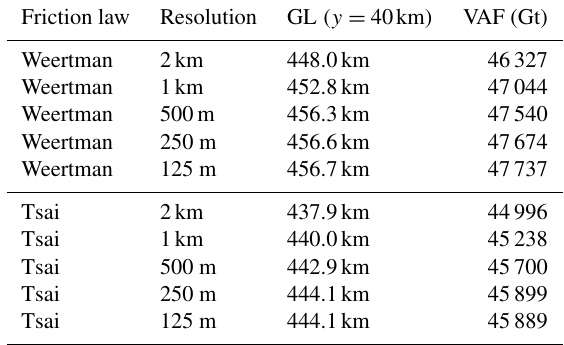
Table 1. Steady-state grounding line position in the glacier center- line and volume above floatation